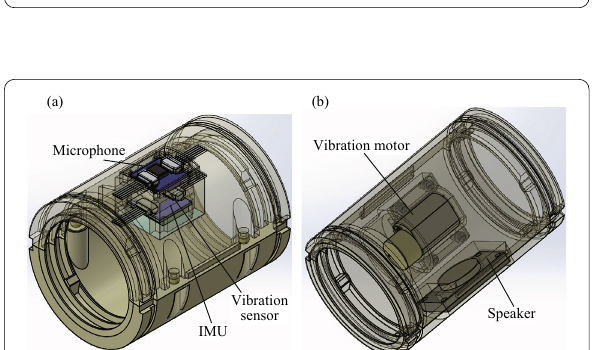
Fig. 7 CAD drawing and photo of the fixed part of the sensor. a Structure of the fixed part of IMU sensor, microphone, and vibration sensor. b Structure of the fixed part of the speaker and vibration